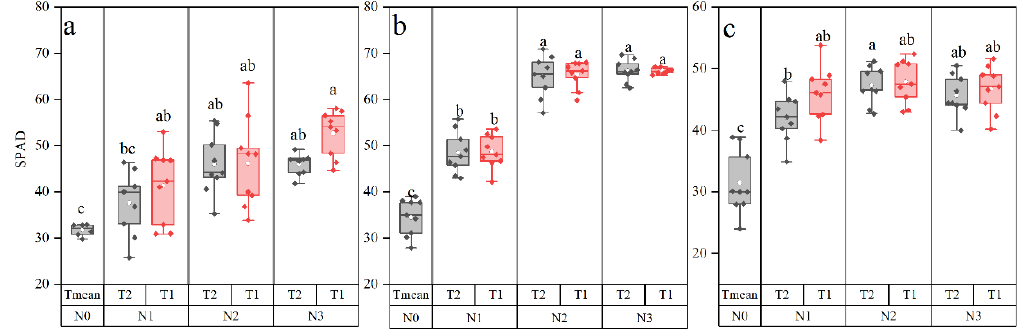
Figure 4. Leaf chlorophyll of maize in 2018 ( a ), 2019 ( b ), and 2020 ( c ) as affected by N supply. Different letters indicate significant differences at p <